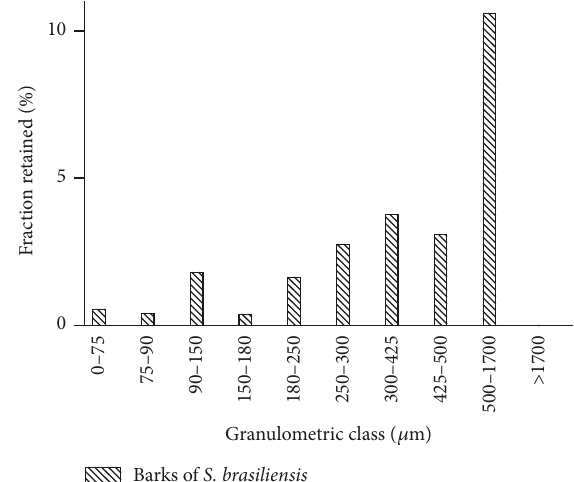
Figure 1: Granulometric distribution histogram of the barks of Schinopsis brasiliensis